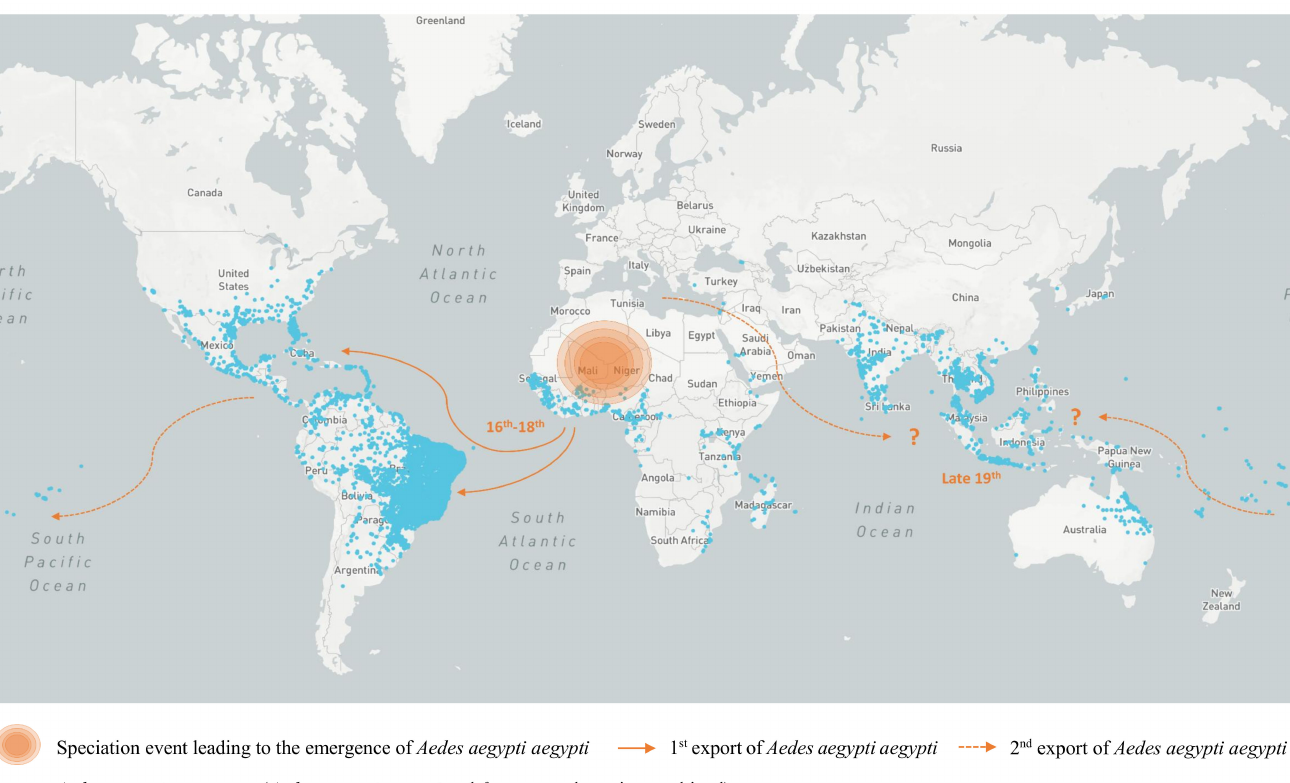
Figure 2. Global dissemination of Ae. aegypti species. Ae. aegypti (Aaa and Aaf subspecies combined) occurrences (adults, pupae, larvae or eggs) are indicated by blue dots. Occurrence data have been retrieved from the global geographic database of known occurrences of Ae. aegypti between 1960 and 2014 compiled by Kraemer and colleagues [137]. The Aaa subspecies most likely emerged during a single sub-speciation event around 4000 years ago, during the severe drying events that accompanied the expansion of the Sahara in the Northern part of Africa [4,119–121]. As confirmed through several genetic analyses performed using either nuclear or mitochondrial markers and microsatellite loci [119–121], Aaa was exported to the Americas during the slave trade. By the end of the 19th century, it was probably introduced from America into Asia. Possible additional introductions from the Mediterranean region may also have contributed to the colonization of Asia by this mosquito